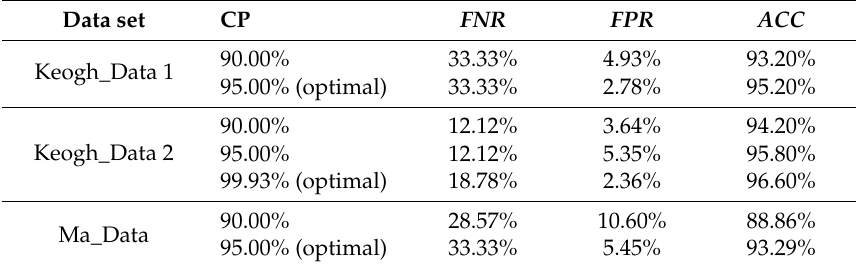
Table 2. Anomaly detection with different CPs based on Gaussian process regression (GPR)